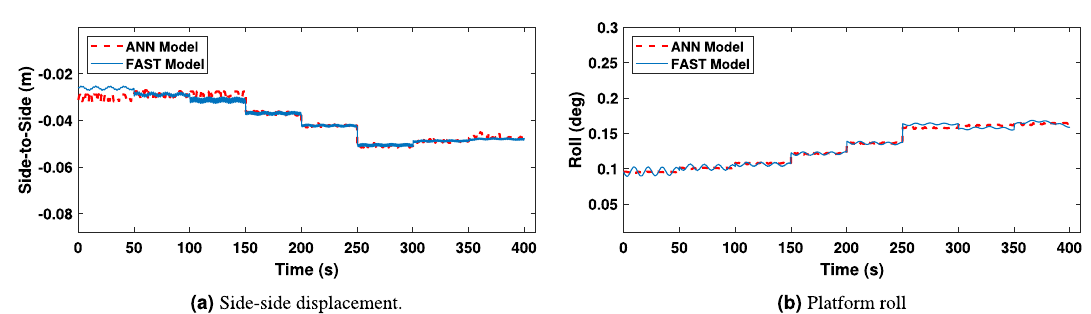
Figure 20. Side-to-side displacement and platform roll in irregular wave condition.